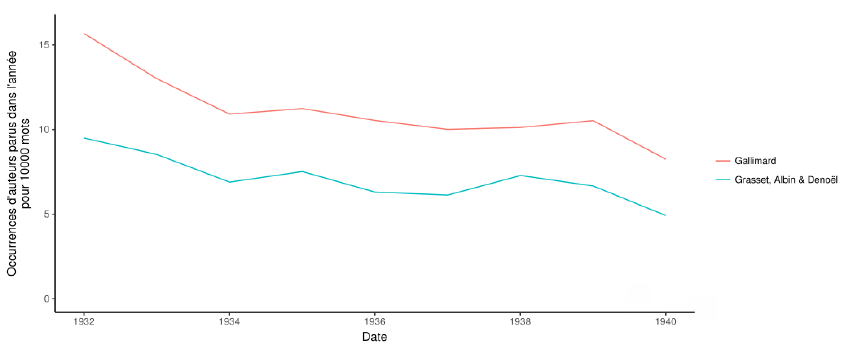
Mention d’auteurs Gallimard et d’auteurs Grasset, Albin Michel et Denoël cités dans l’année pour 1000